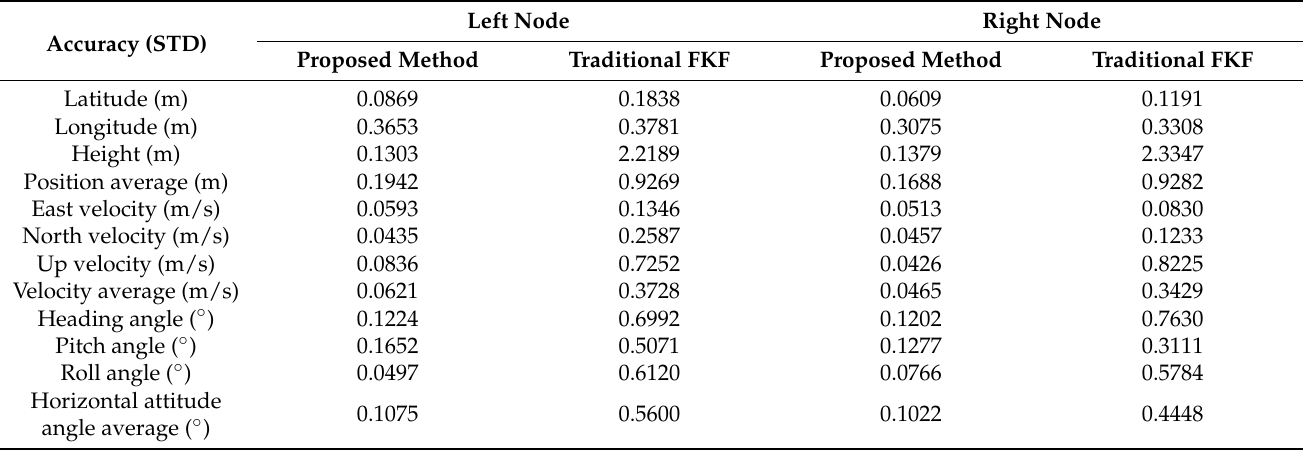
Table 3. STD accuracies of position, velocity and